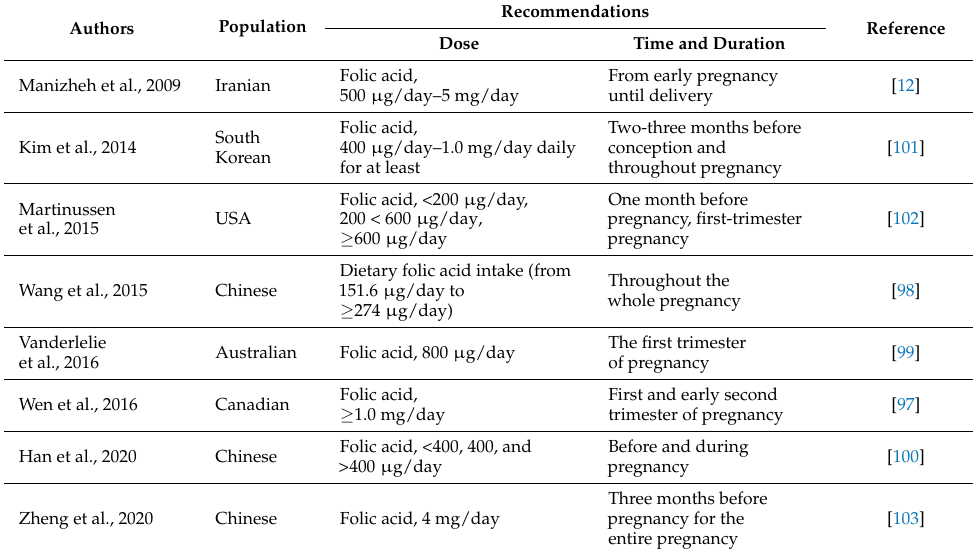
Table 1. Folic acid supplementation for preeclampsia